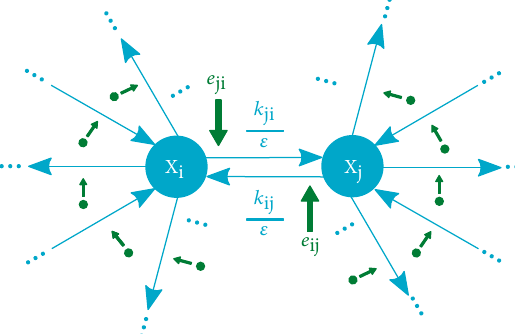
Figure 2: Enzymatic reactions between metabolites in QSS depicted in Figure 1. The metabolites inside the subnetworks are substrates or products of fast reactions catalyzed by an